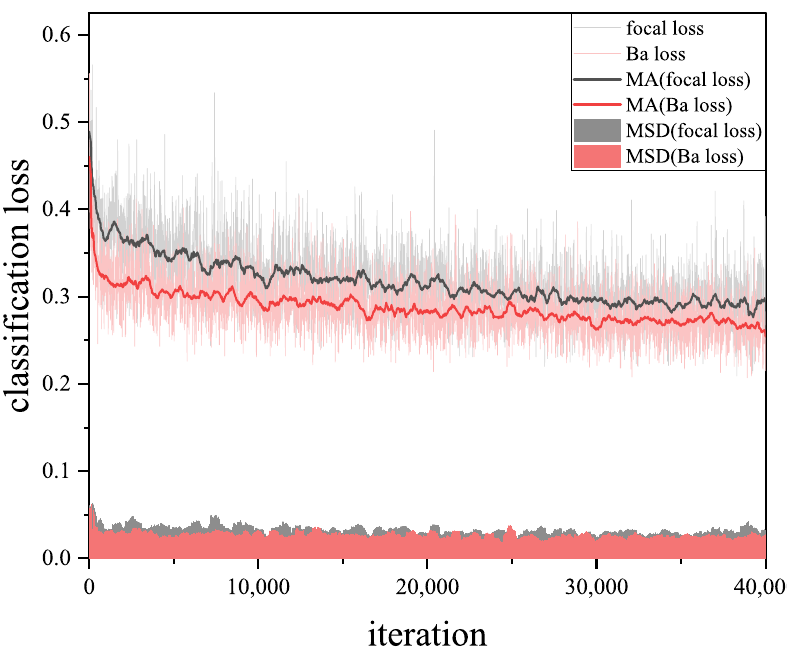
Figure 10. Comparison of different classification losses. MA = Moving Average; MSD = Moving Standard Deviation.